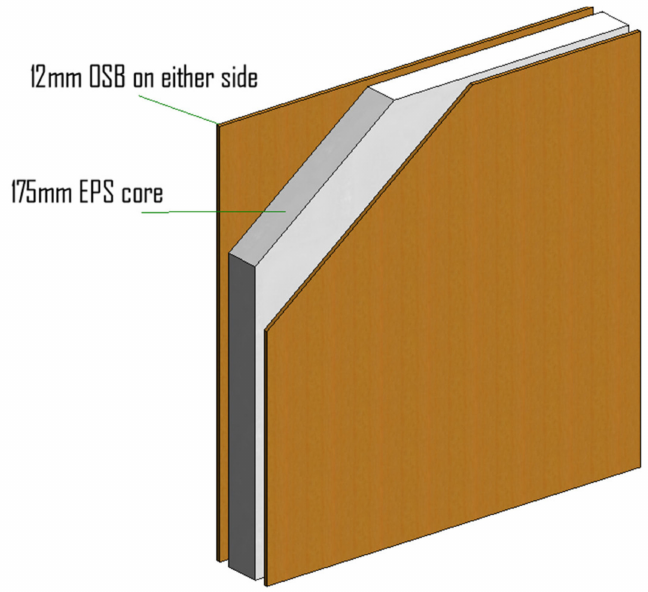
Figure 1. Structural Insulated Panel with typical material thicknesses. Note: OSB = oriented strand board, EPS = expanded